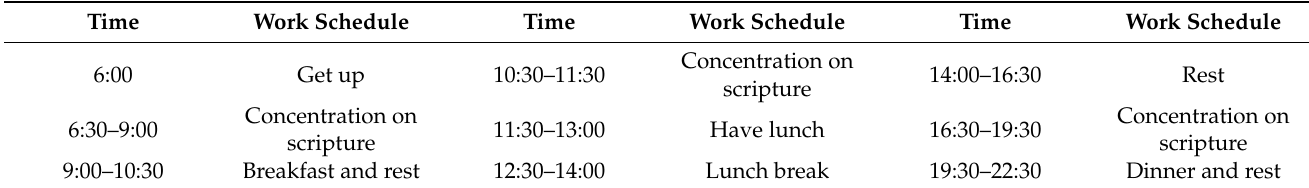
Table 1. Monastic work schedule.